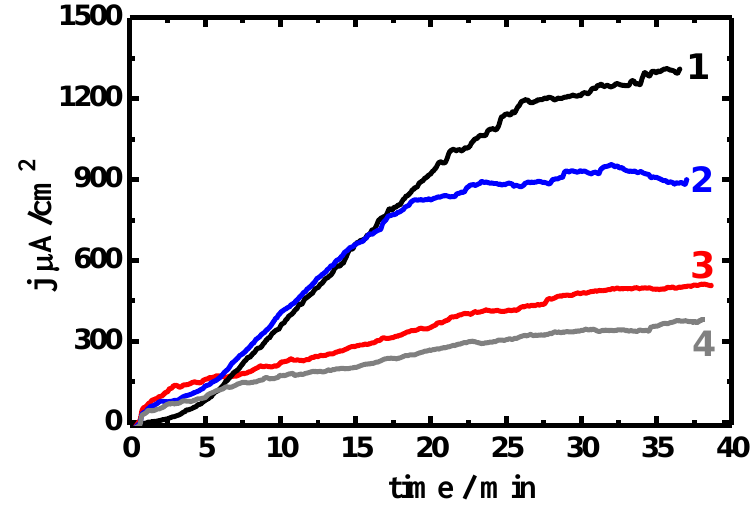
Figure 7. PCT curves gathered at −680 mV for 6061 alloys, ( 1 ) the as received and the extruded alloys at ( 2 ) 350, ( 3 ) 425, and ( 4 ) 500 °C after their immersion in 3.5% NaCl solutions for 24 h.